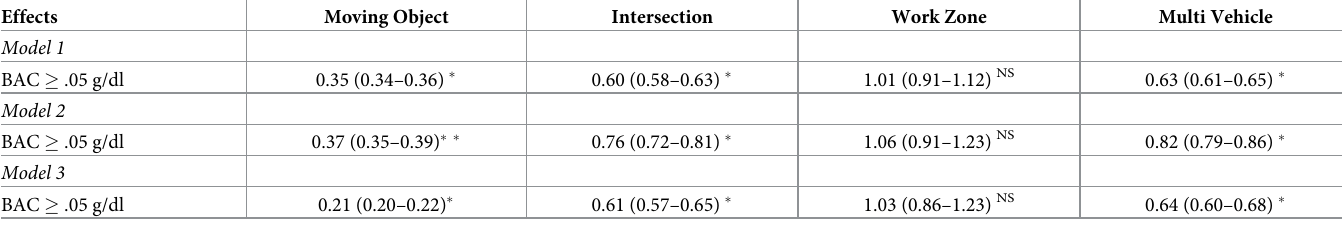
Table 1. Adjusted Odds ratios of alcohol-involved drivers crashing in relatively more complex environments under different analytic assumptions.